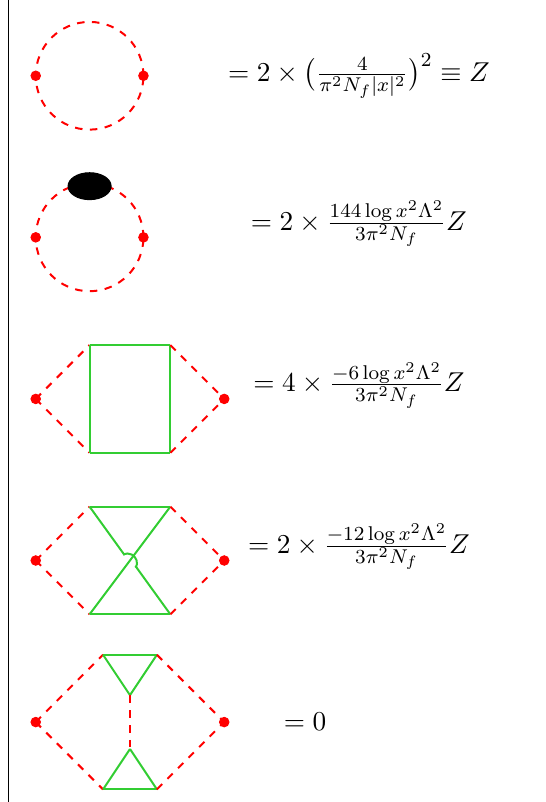
Table 11 . (QED-GN + ) Feynman graphs appearing in the 2-point correlation function of the com- 14 . The black ellipse in the second diagram means dressing HS (cid:12)eld propagator posite operator (cid:26) 2 + with graphs in the left column of